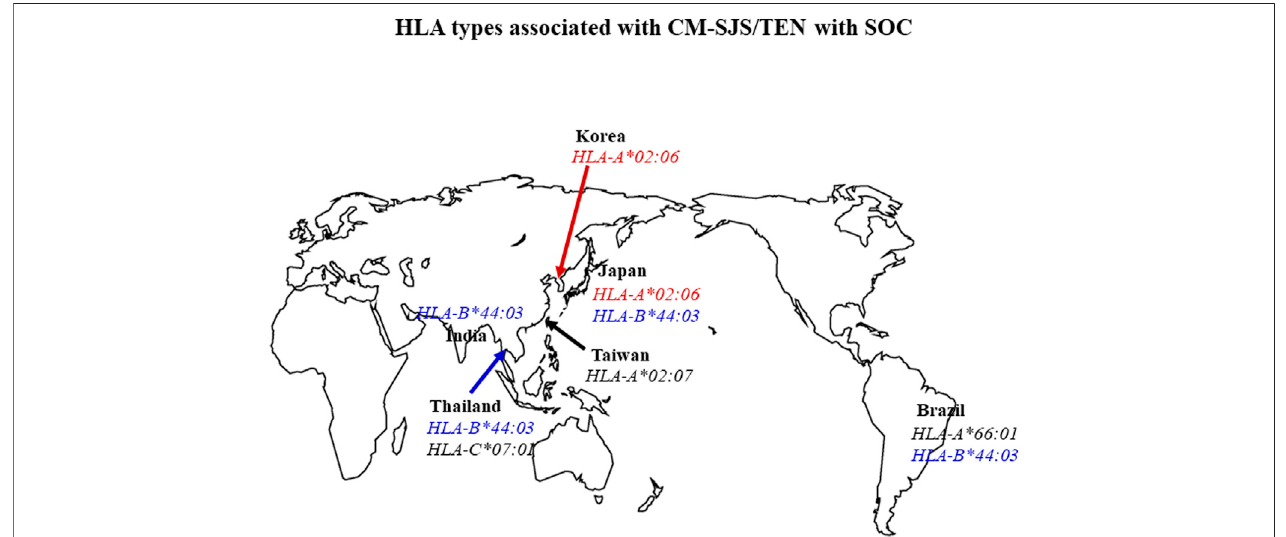
FIGURE1| SummaryoftheassociationbetweenHLAtypesandCM-relatedSJS/TENwithSOC. HLA-B*44:03 wassigni fi cantlyassociatedwithCM-related SJS/ TEN with SOC in Japanese, Brazilian, Indian, and Thai populations. HLA-A*02:06 was signi fi cantly associated with CM-related SJS/TEN with SOC in Japanese and Korean patients (OR: odds ratio